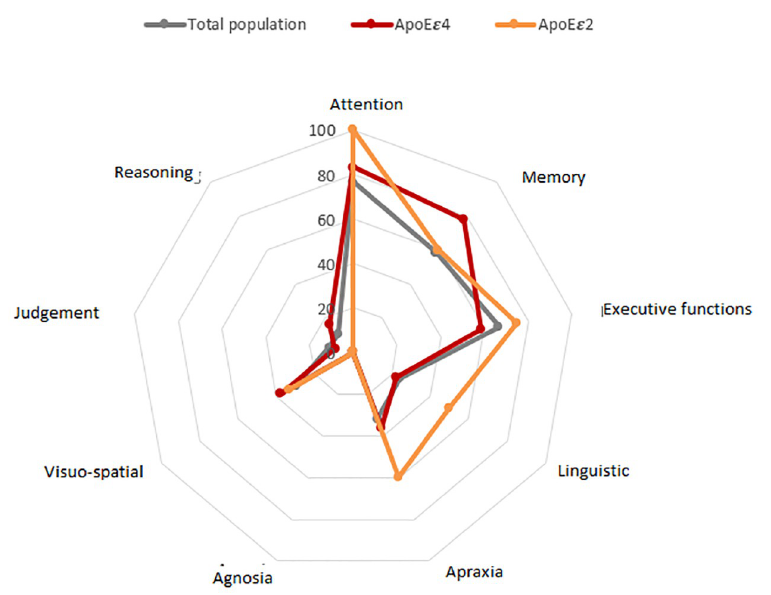
Fig 2. Remodeling of cognitive profile according to the carriage of APOE ε 4 and APOE ε 2 isoforms. Radar charts comparing the altered cognitive domains in percentage (%) between two subtypes of AMS-C and